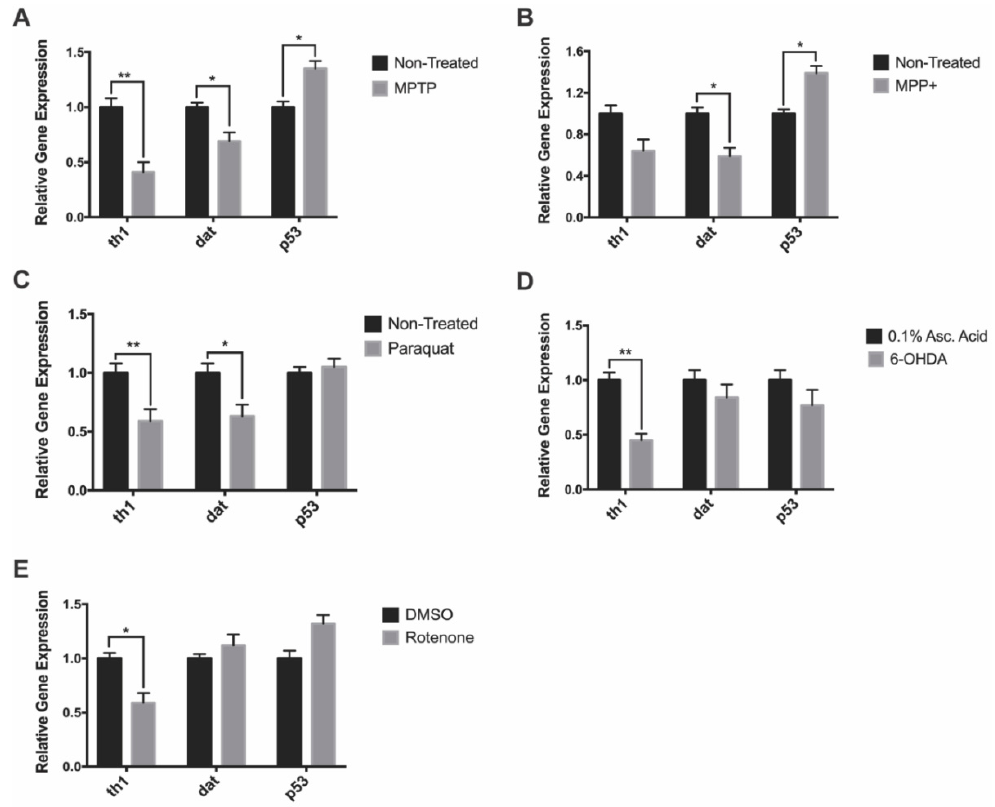
Figure 4. Impact of neurotoxin exposure on dopaminergic- and apoptosis-linked gene expression. ( A – E ) Relative expression of dat , th1 , and p53 of 7 dpf zebrafish following exposure to MPTP, MPP + , paraquat, 6-OHDA, and rotenone ( n = 3 pools of 10 larvae). Bars represent the Mean ± the SEM. * ( p < 0.05) and ** ( p <